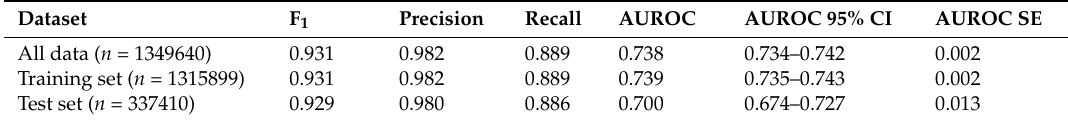
Table 3. Performance of DNN across all data, the training set, and the test set.